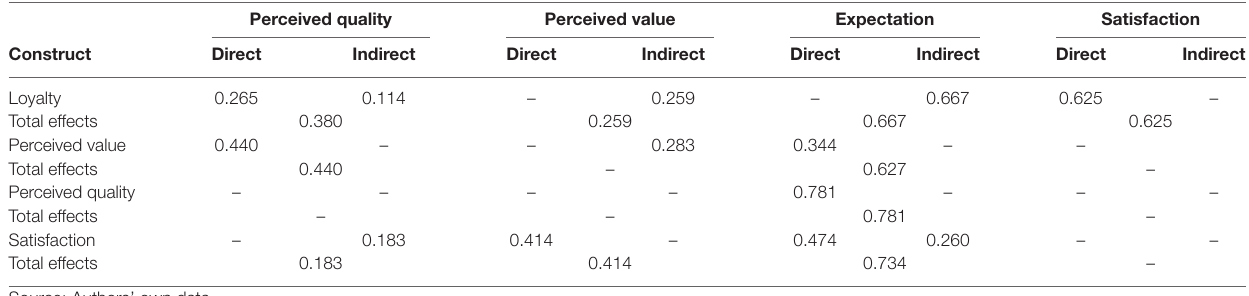
FIGURE 2 | Structural model. * p < 0.001;** p < 0.01. χ 2 (df7) = 65.807 ( p = 0.000), GFI = 0.940, AGFI = 0.887, CFI = 0.966, RMSEA = 0.088, χ 2 -normalized ( χ 2 /df) = 2.742. Direct, indirect, and total